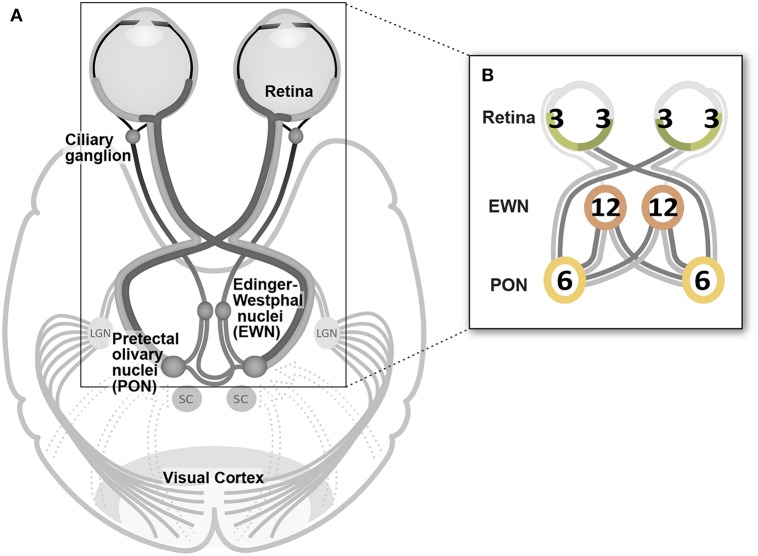
(A) Decussating and non-decussating input from retinal neurons arrives at the pretectal olivary nucleus (PON) via the brachium of the superior colliculus (SC) as well as from various regions of visual cortex. Axons of PON neurons project bilaterally to left and right Edinger-Westphal nuclei (EWN) forming a second hemi-decussation in the pathway. Parasympathetic fibers originating in the EWN travel within the inferior branch of the oculomotor nerve to the ciliary ganglion from where the fibers of the short ciliary nerves project to innervate the pupil constrictor muscle. (B) In the Results section, the temporal density of the luminance signal is indicated at each synapse in the pathway as shown in this example. Numerals reflect the amount of input arriving at each nucleus as the sum of the average total stimuli presented to each individual hemiretina (nasal or temporal) during a one second interval. Color coding reflects this: signal from 3 stimuli s−1 is shown in green, 6 stimuli s−1 hemiretina−1 in yellow, and 12 stimuli s−1 in orange. These signal densities are manipulated in the different experimental conditions (Table 1). As shown in this cartoon, lighter and darker hemiretinas, and projections as far as the EWN indicate the presence of temporal and nasal retinal signal, respectively, for each specific experimental condition.